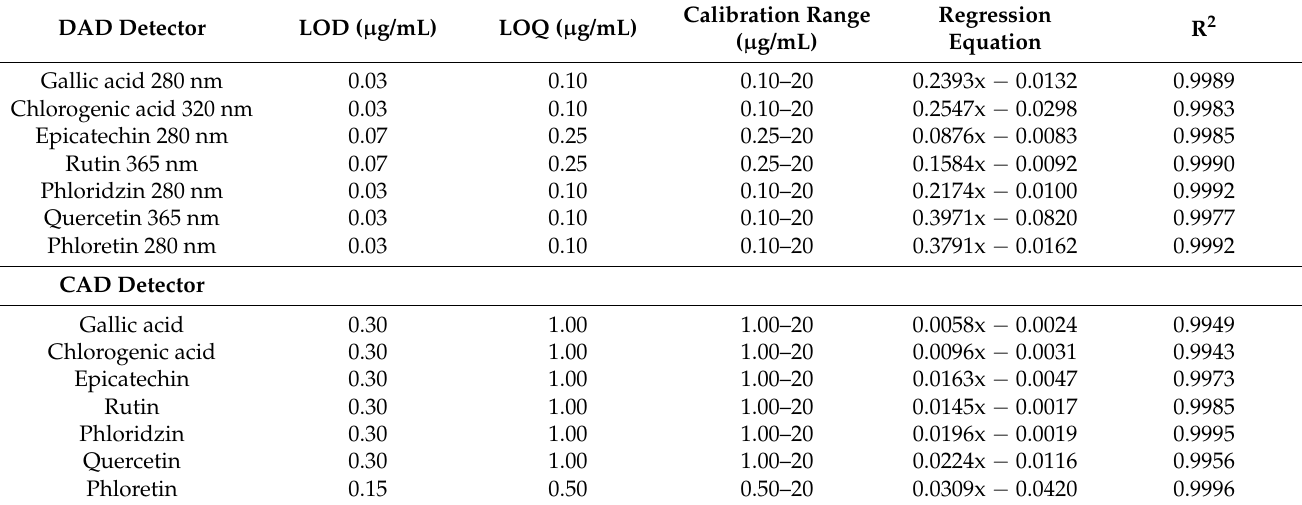
Table 2. Limits of detection and quantitation, calibration ranges, regression equations, and determination coefficients using diode-array (DAD) and charged aerosol (CAD) detectors. Separation conditions: gradient elution with mobile phases aqueous acetic acid with pH 2.8 (A) and acetonitrile (B), gradient profile 10–50% B in 10 min, 50% B 0.2 min, 50–10% B